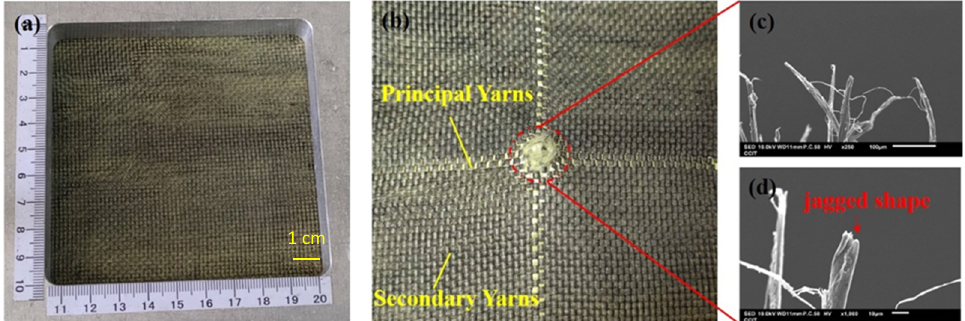
Figure 6. Observation of the single-ply ( a ) Polyurea Elastomers/Kevlar fabrics before the ballistic test; ( b ) failed fabric with Polyurea Elastomers/Kevlar fabrics after the ballistic test; ( c ) the close-up look of the failed fibers in ( b ); ( d ) the zoomed-in im-age of the failed fibers in ( c ).